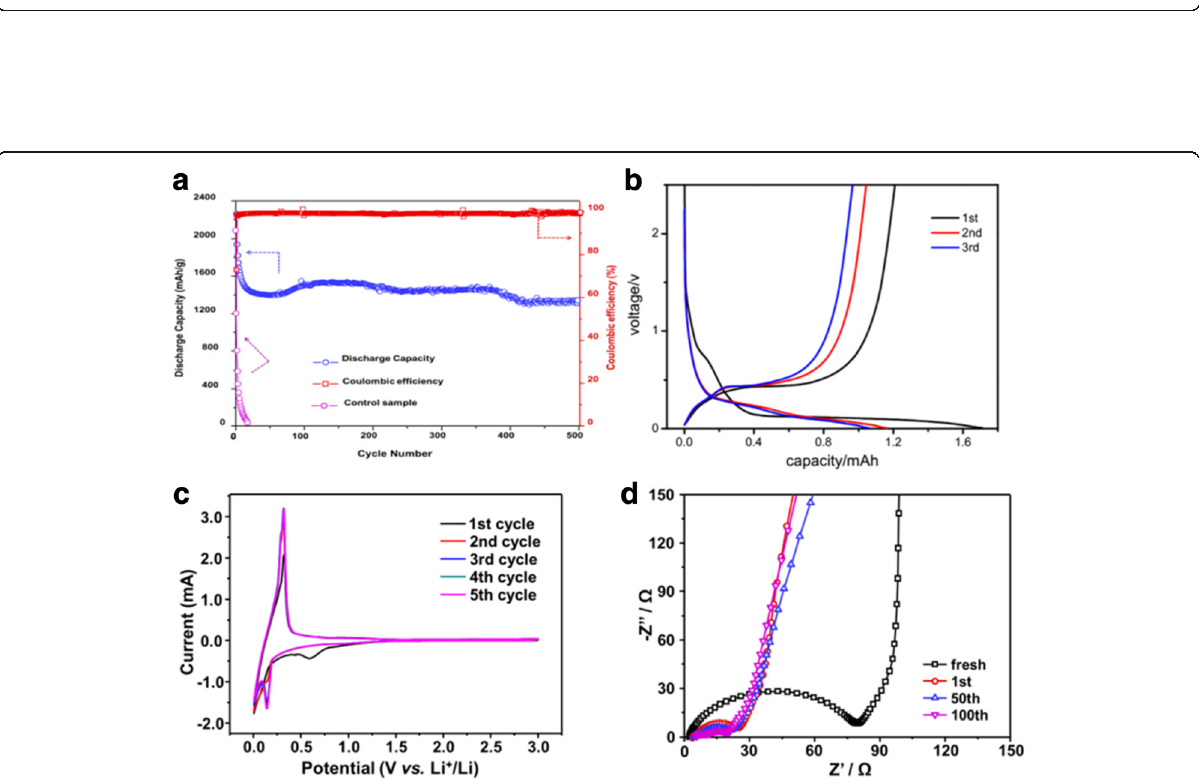
Fig. 3 TEM characterizations for the nano-Si/SiO x matrix sample. a Particle morphology. b Particle observation under high magnification shows the crystalline Si core and amorphous oxide surrounding. c STEM/EDX elemental mapping prove the miscible feature of Si and O. d Image of Si/C yolk/shell structure